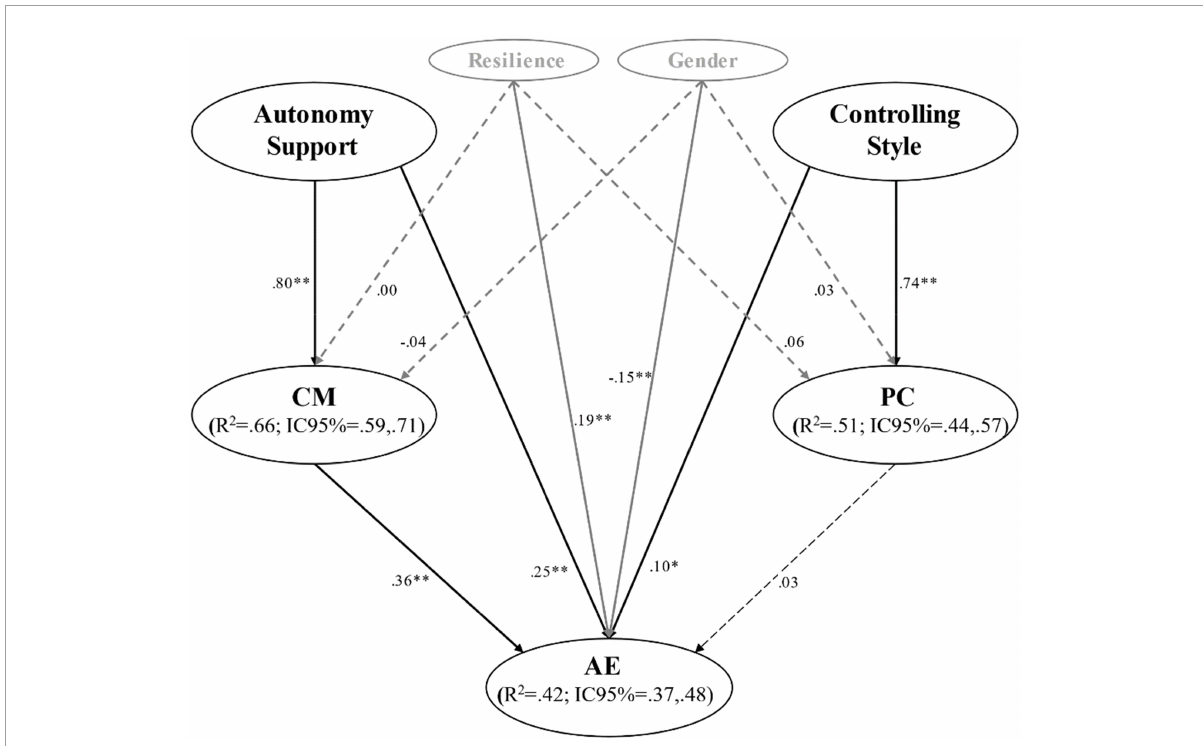
FIGURE2 Predictive relationships of the interpersonal teaching style on academic engagement through the mediating role of the motivational climate, controlling the gender and resilience variables. ∗∗ p < 0.001. AE, Academic engagement; MC, Motivational climate; PC, Performance climate; R 2 , Explained variance; CI, Confidence interval. The dashed lines represent non-significant